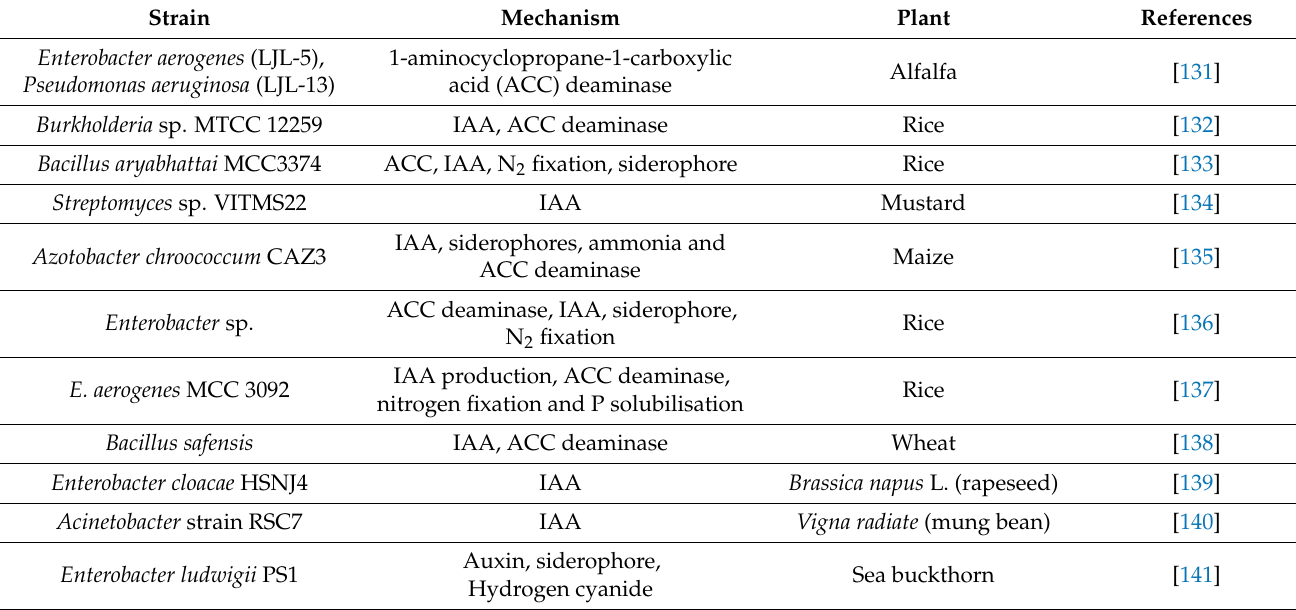
Table 2. Plant growth-promoting mechanisms induced by